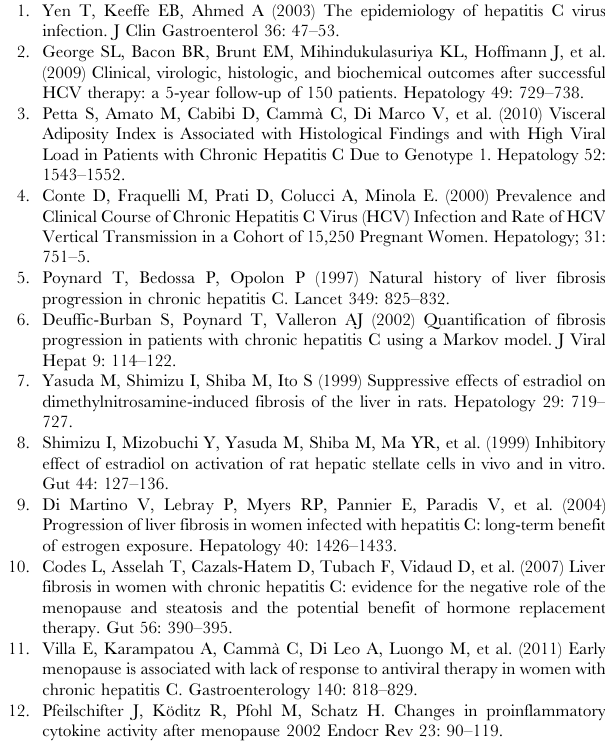
Table S1 Comparison between female and age-matched male patients with chronic hepatitis. Table S2 Comparison between female and age-matched male patients with chronic hepatitis. Table S3 Comparison between the four groups of female patients with chronic hepatitis C. Table S4 Comparison between the four groups of female patients with chronic hepatitis